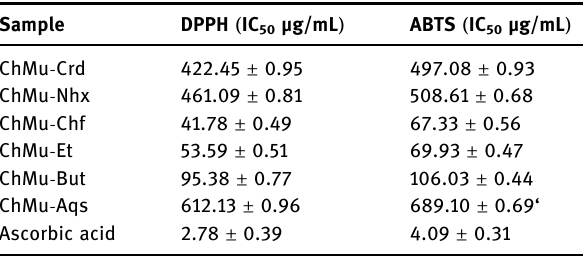
Table 5: Antioxidant activity of extract and fractions of C. murale